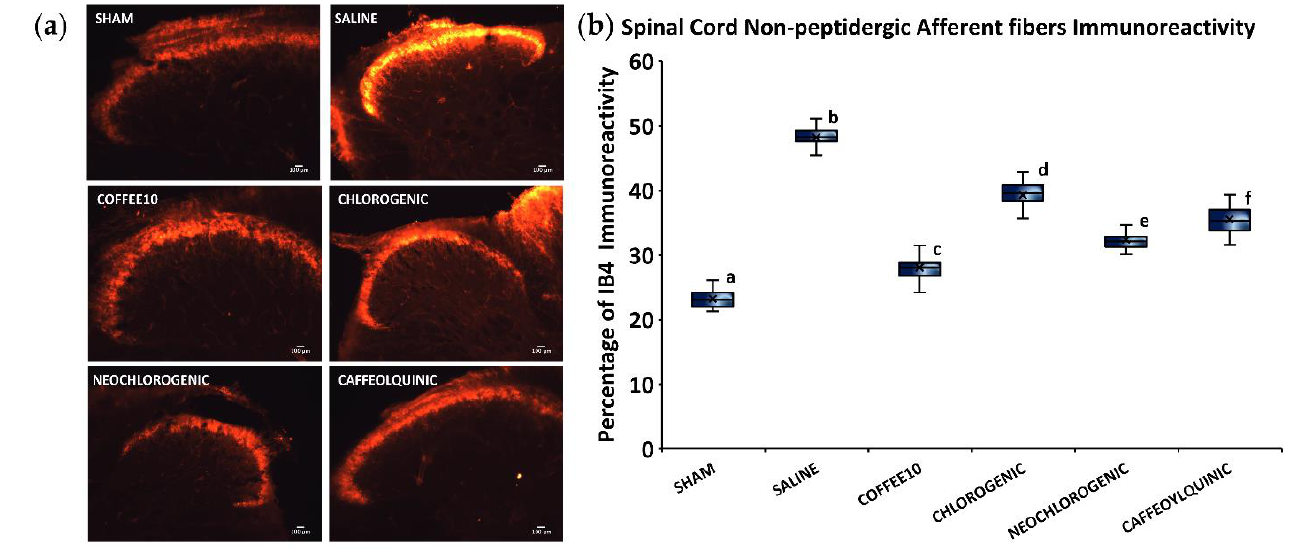
Figure 6. Sprouting of non-peptidergic afferent nerve fibers in the spinal cord after polyphenolic treatments fourteen days post-injury. ( a ) Representative IB4 images for each group. Scale bars = 100 µ m. ( b ) Percentage of dorsal horn IB4 immunoreactivity. Data are illustrated as median ± IQR, and the x